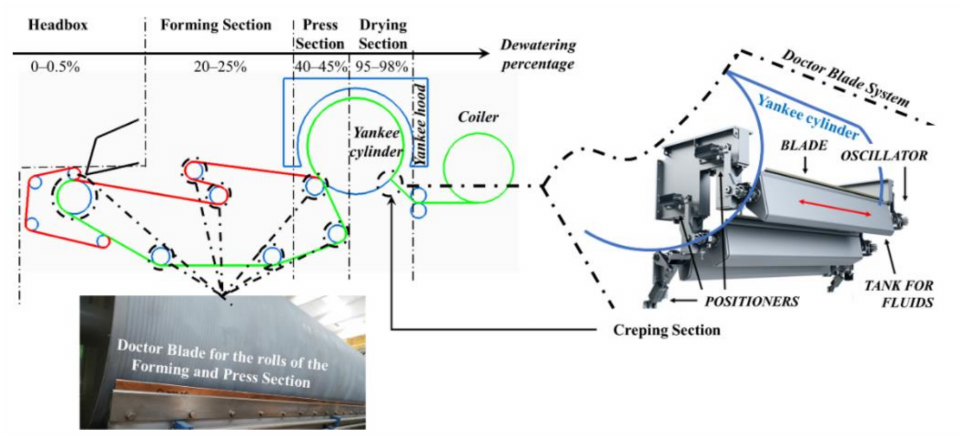
Figure 1. Scheme of a TPM process and details about Doctor Blade. Red colored lines represent the fabric moving in the Forming Section. Continuous paper web and paper tissue are represented by green colored